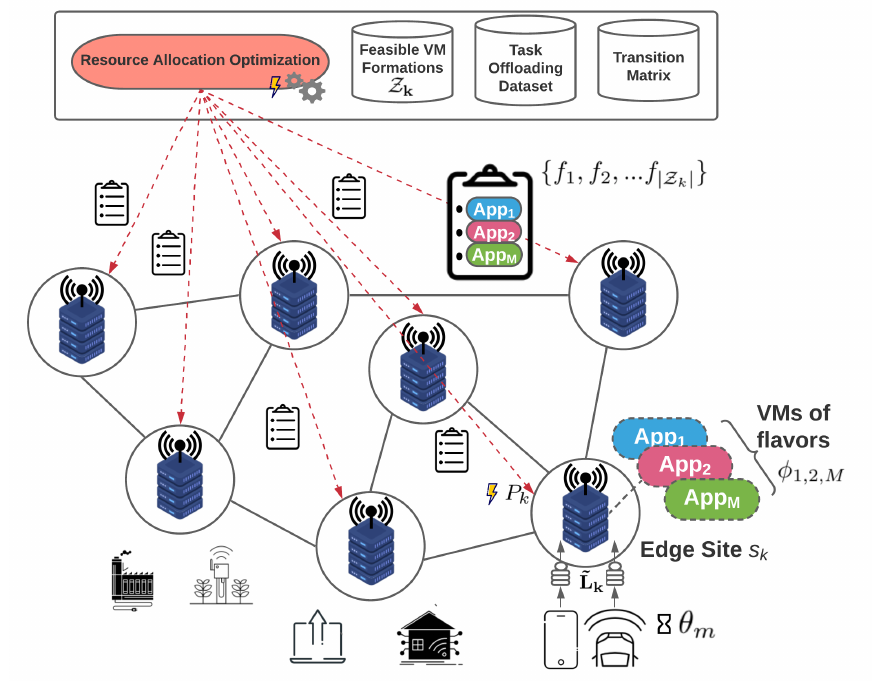
Figure 2. Resource allocation optimization overview (Stage